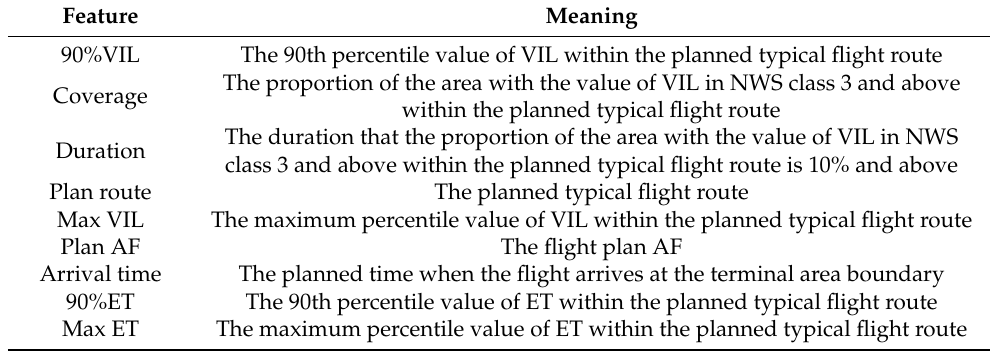
Table 2. Features and meaning.